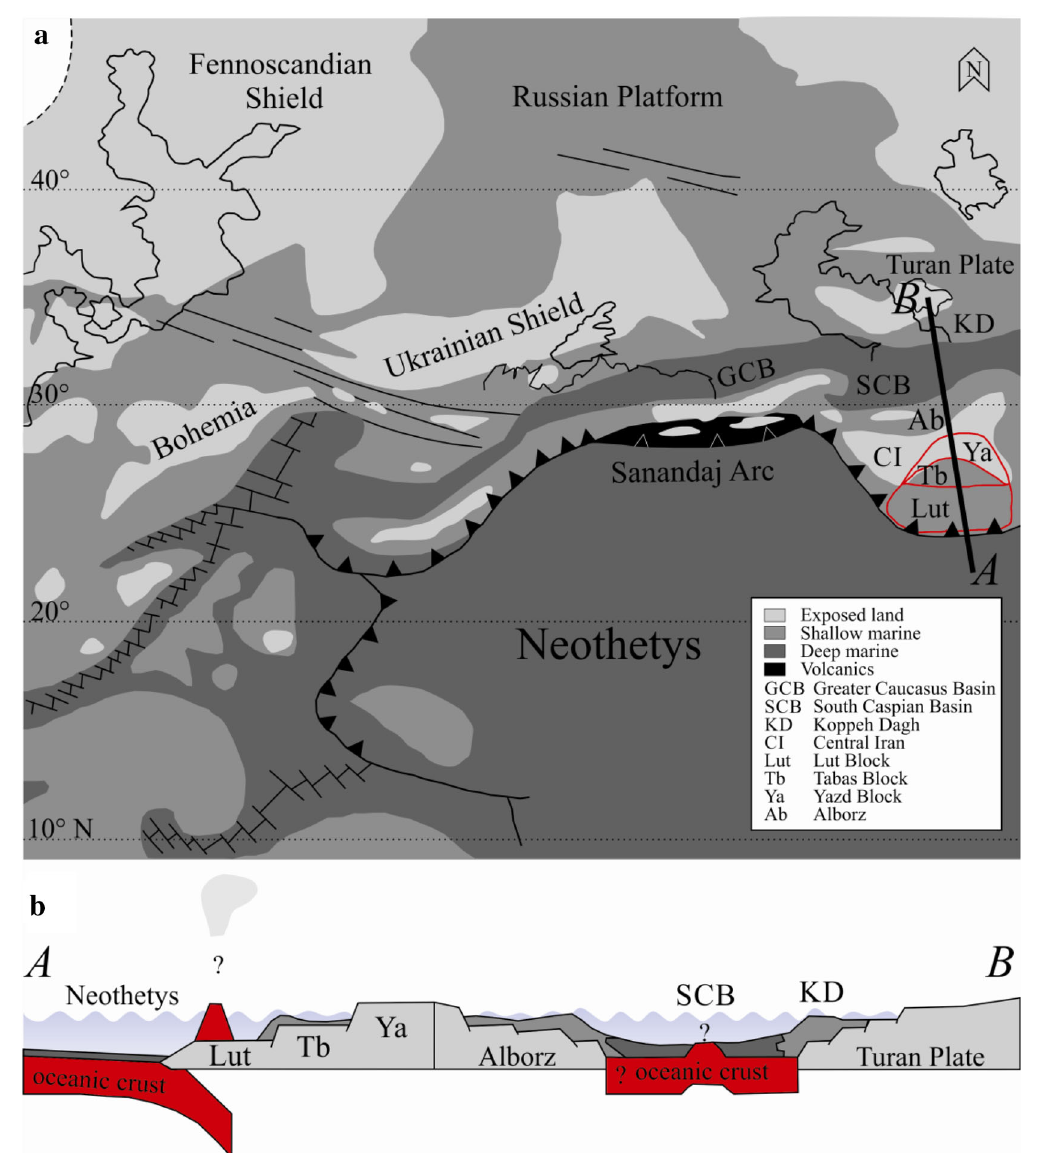
Fig. 2 a Palaeogeographic map of the western Neothetys during the middle Jurassic with the situation of the Central-East Iranian Microcontinent marked in red, b cross section along AB line. Modified after Wilmsen et al.